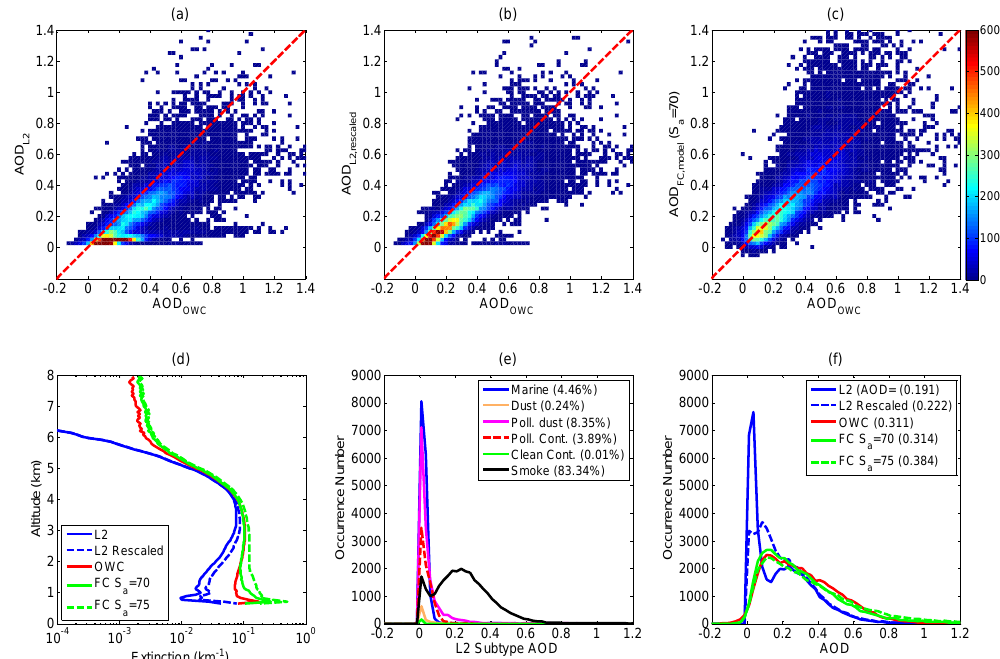
Figure 12. Analysis results for the smoke transport region as indicated by the red box in Fig. 7. The top row shows 2-D distributions of (a) AOD L2 vs. AOD OWC , (b) AOD L2, res vs. AOD OWC , and (c) AOD FC, mod vs. AOD OWC for S a =70sr. Full column AOD using modeled dust S a = 40sr vs. AOD OWC . The bottom row shows (d) extinction profiles and histograms of occurrence number, (e) L2 AOD of different aerosol types, and (f) AOD retrieved using different retrieval methods. The bin size for AOD is 0.025.